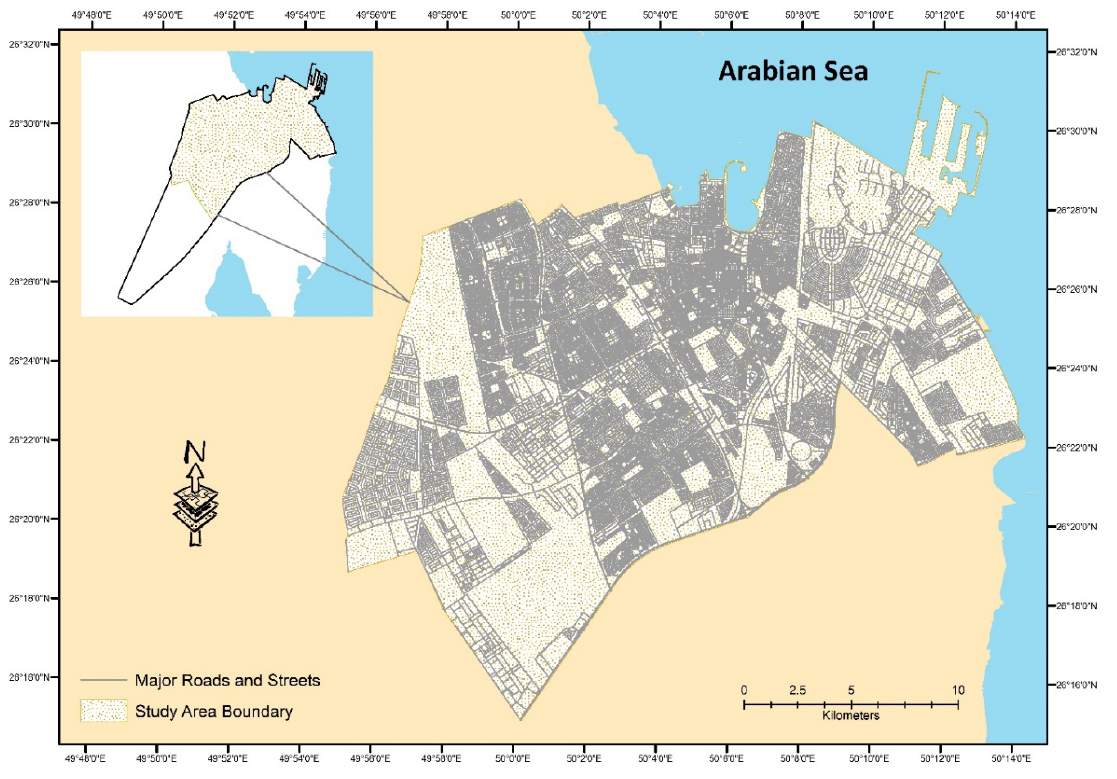
Figure 1. Study area within the City of Dammam.